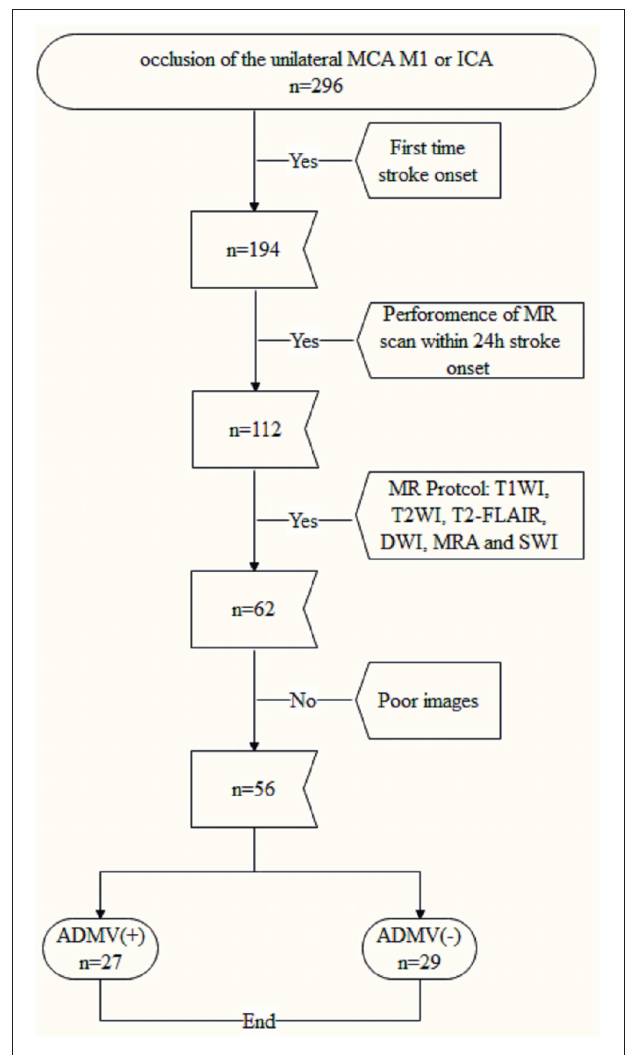
FIGURE 1 | Flowchart of enrollment of study